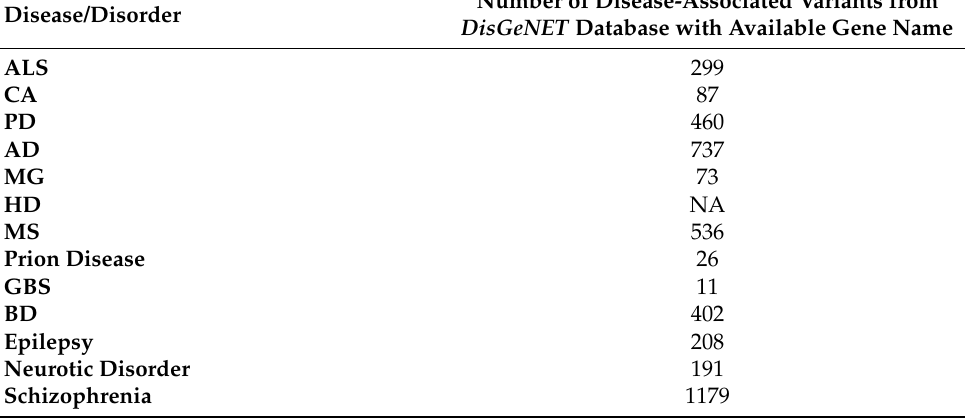
Table 1. Disease-associated variants collected for the included neurological diseases and neuropsy- chiatric